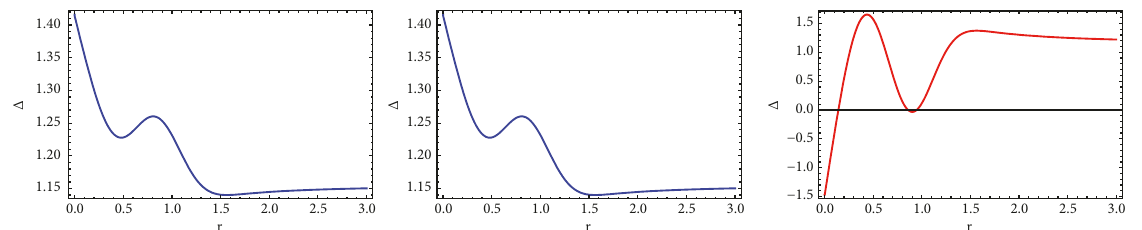
Figure 10: This figure represents the variation of Δ versus 𝑟 (km) for the strange star taking 𝛽 = 1 , 𝛽 = −6 , and 𝛽 = −15 .